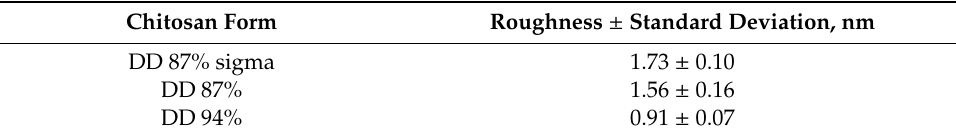
Table 1. The average roughness R a of chitosan